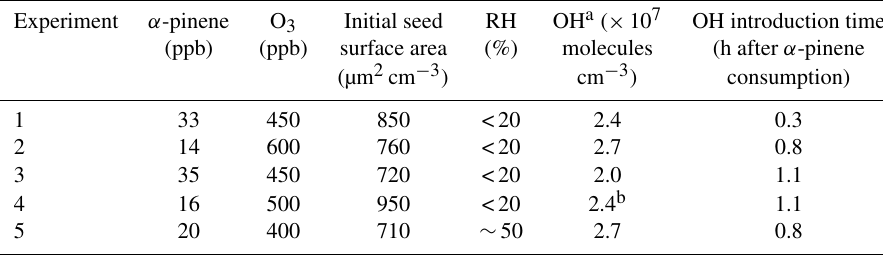
Table 1. Initial conditions of the α -pinene ozonolysis aging experiments. Experiment α -pinene O 3 Initial seed RH OH a ( × 10 7 OH introduction time (ppb) (ppb) surface area (%) molecules (h after α -pinene (µm 2 cm − 3 ) cm − 3 ) consumption) 1 33 450 850 <20